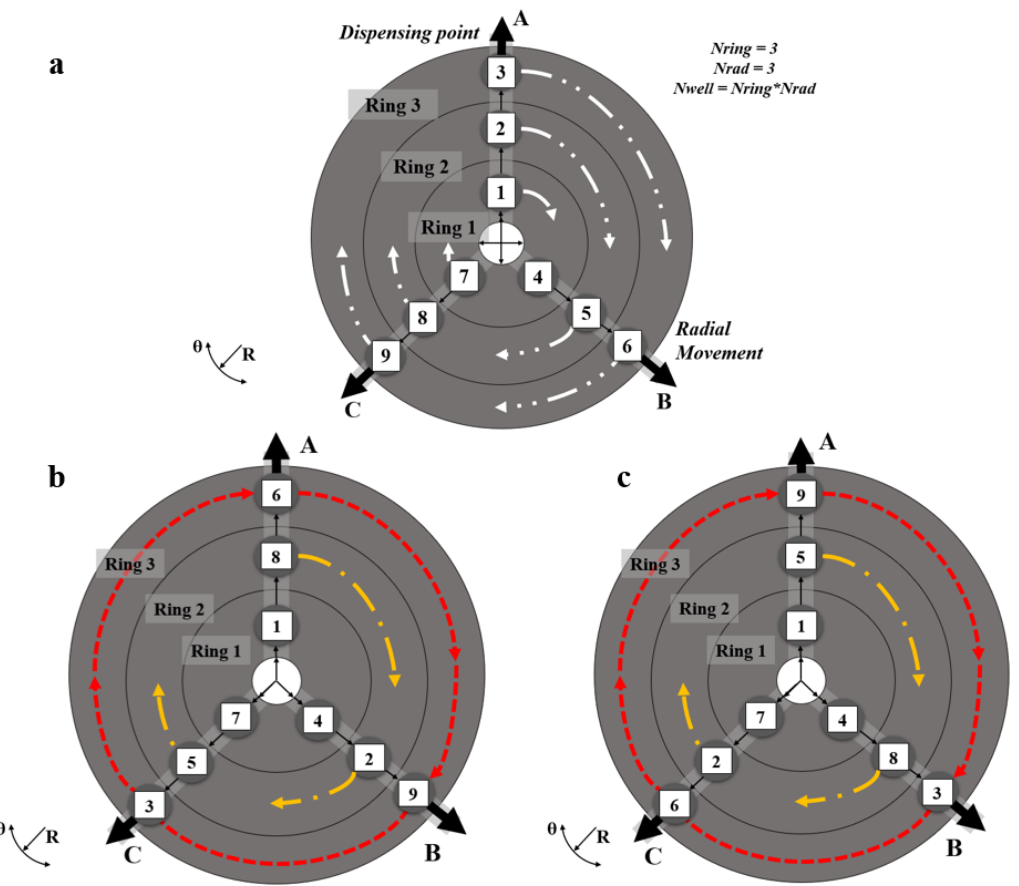
Figure 4. Three-by-Three Configuration. ( a ) Overview of a 3 × 3 configuration. Drug combinations occur through either circumferential movement, the movement of a droplet from a well on one radius to a well on another radius, or through radial movements, the movement of a droplet along the same radius. There is a total of 84 combinations, requiring 28 positions for all combinations. ( b ) shows rotor position after movement. The movement of a droplet on ring 2 from a well on radius 1 to a well on radius 2 (a. 120° rotation) and a droplet on ring 3 moving from a well on radius 1 to a well on radius 3 (a 240° rotation). ( c ) shows the next positions following ( b ). A, B and C are the outlet lines.